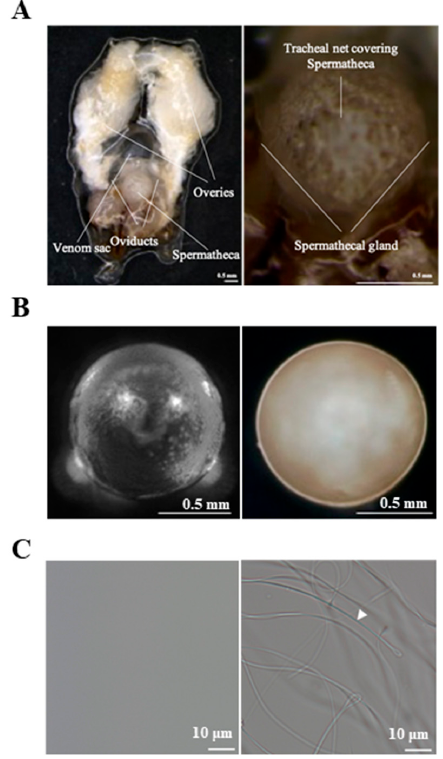
Figure 1. The reproductive organs, spermathecae, and sperm of A. mellifera queens. ( A ) The repro- ductive organs of the A. mellifera queen 24 h after mating. ( B ) The spermathecae of the virgin queen (Left) and the mated queen 24 h after mating (Right). ( C ) The spermathecal fluid of the virgin queen (Left) and the mated queen 24 h after mating (Right). The sperm in the spermathecal fluid of mated queens is indicated by